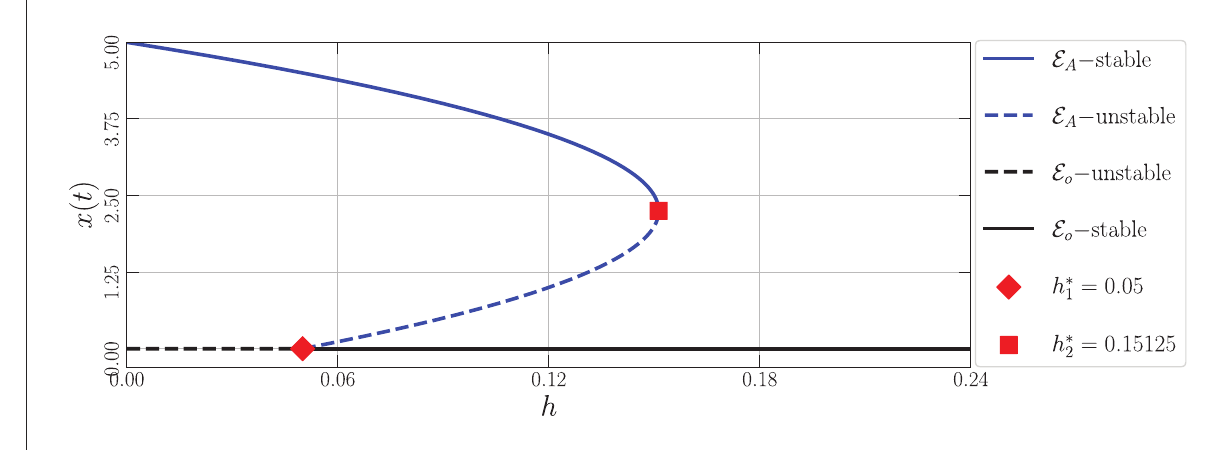
FIGURE1 Bifurcation diagram driven by the harvesting rate ( h ) of the model (Equation 3) around the axial point using the parameter values: r = 0.1, K = 5, m = 0.25, c = 0.5, n = 0.01, β = 0.06, δ 1 = 0.05, δ 2 = 0.05, ω = 0.1, and α = 0.9.